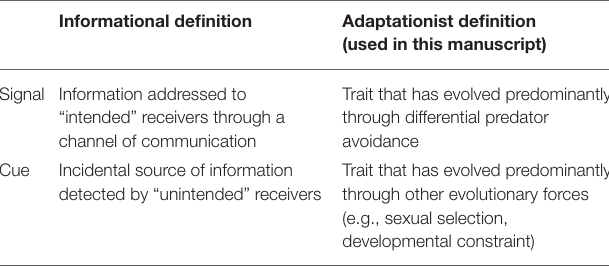
TABLE 1 | Informational and adaptationist definitions of signal and cue in the case of protective mimicry. Informational